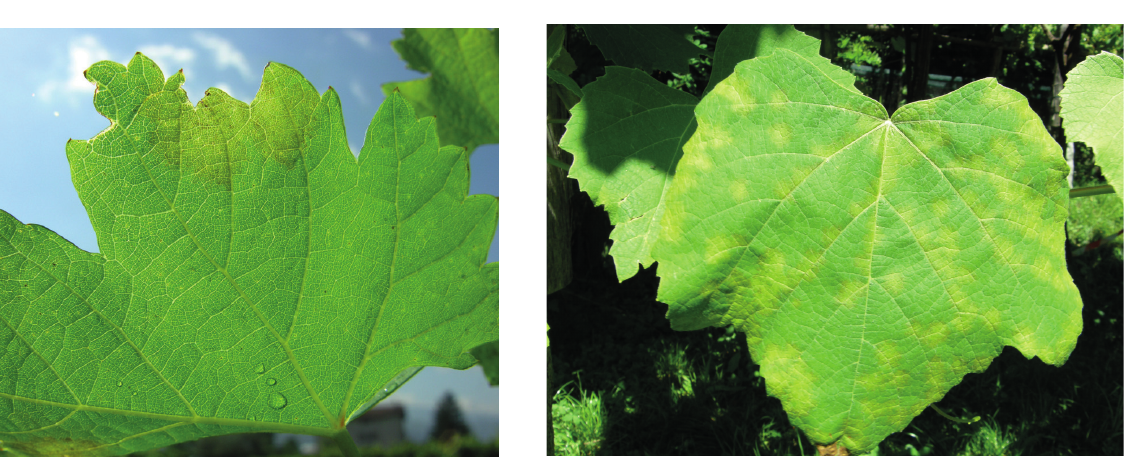
Figure 1. oilspot caused by Plasmopara viticola.